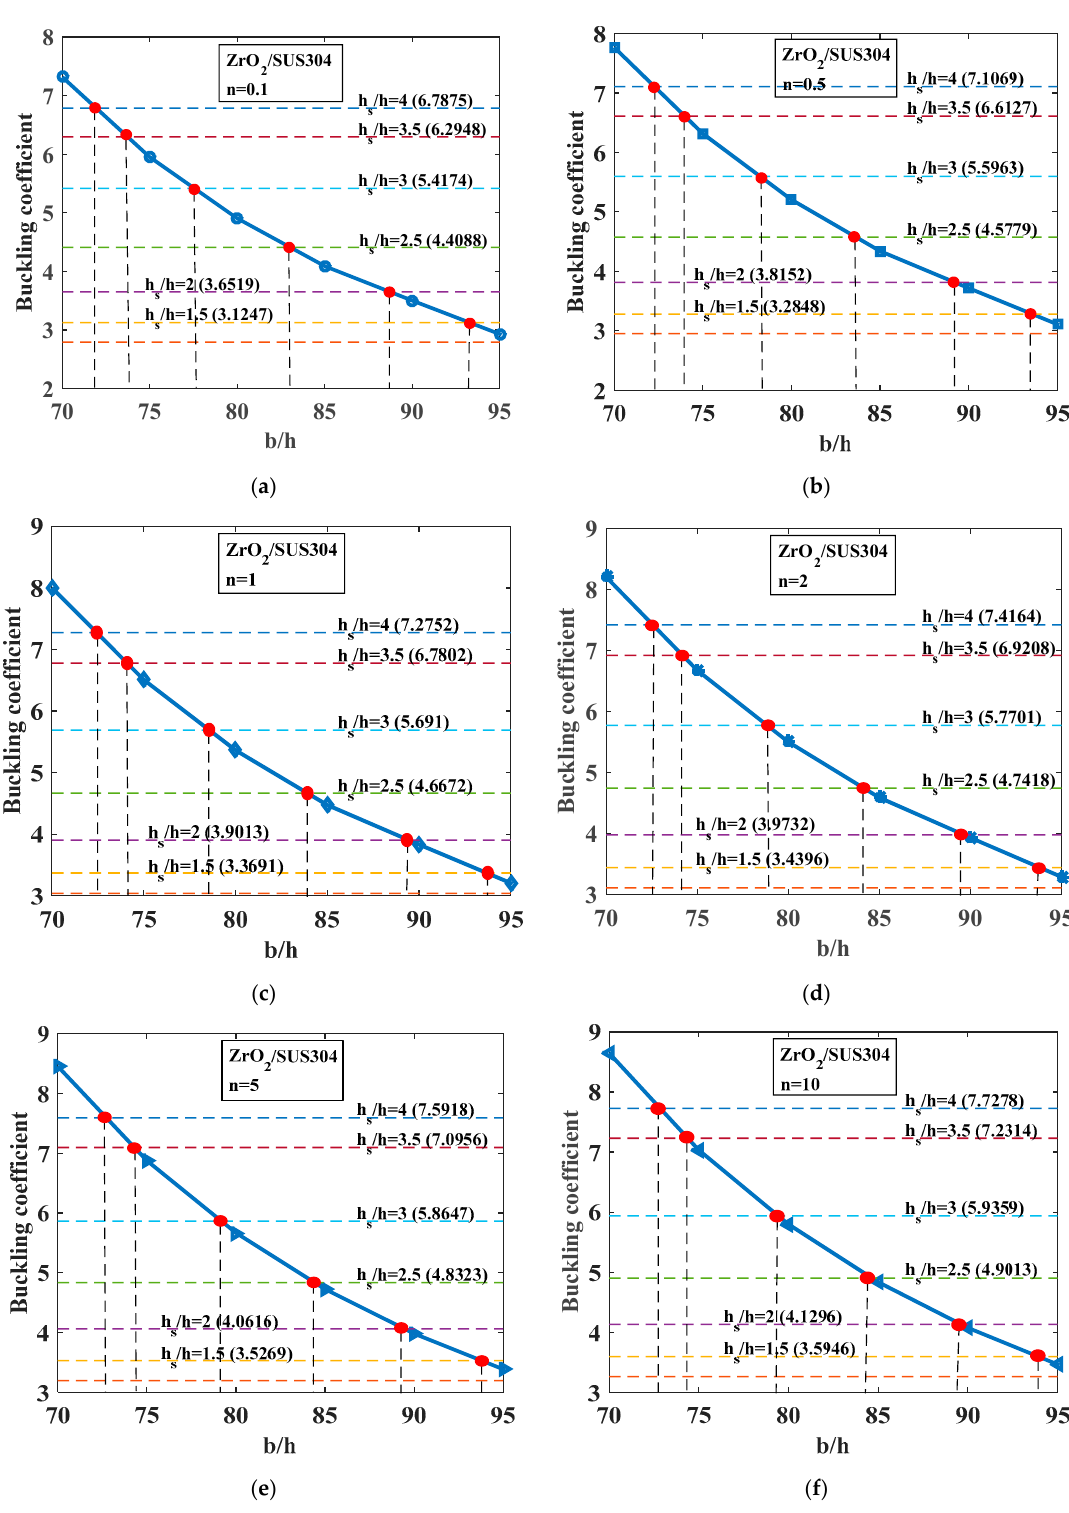
Figure 5. Buckling coefficient of FGM (ZrO 2 /SUS304) plate. Solid blue line: buckling coefficient of plate without stiffeners ( b / h = 70–95); horizontal dash-dot line: buckling coefficient of plate that has central stiffener ( b / h = 100) with various h s / h ratios. ( a ) n = 0.1; ( b ) n = 0.5; ( c ) n = 1; ( d ) n = 2; ( e ) n = 5; ( f ) n =10.